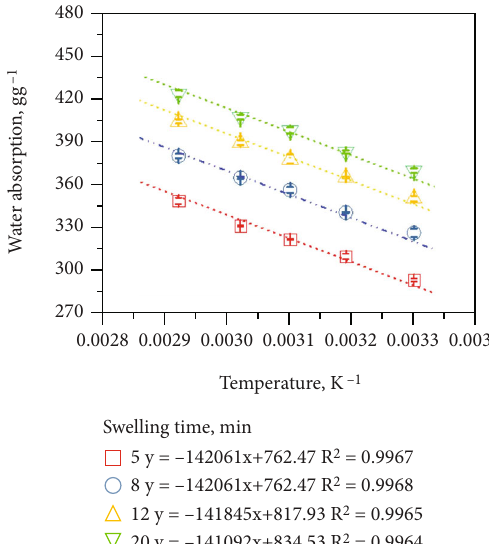
Figure 3: E ff ect of salinity on the acrylic SAPs ’ swelling (sample 5#). Figure 4: E ff ect of temperature on the acrylic SAPs ’ swelling (sample 2#).